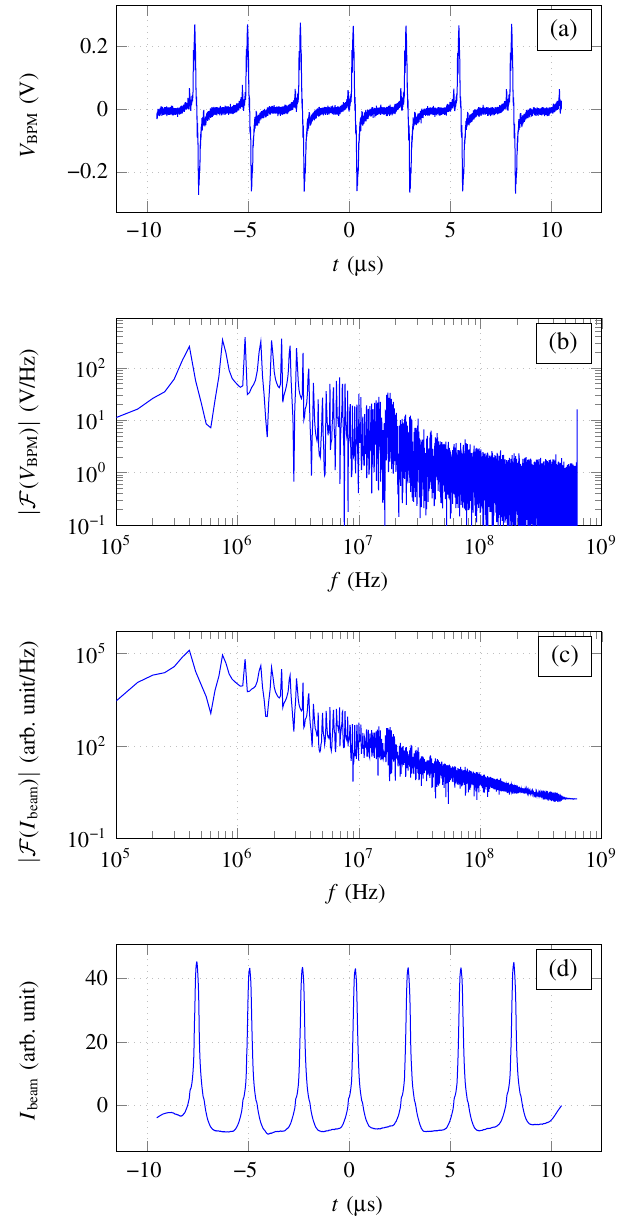
FIG. 7. Example of the procedure for processing BPM data frames (500 ns electron bunches; V